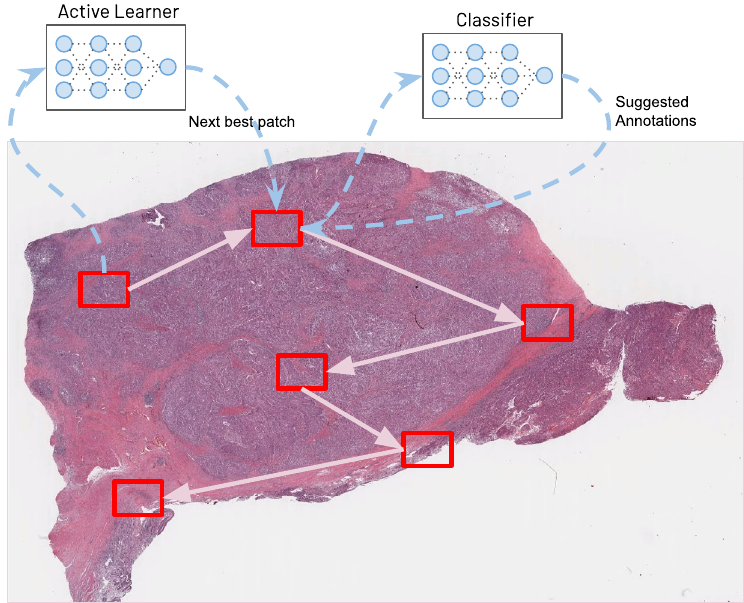
Fig. 1 HALS: human-augmenting AI-based labeling system. As a human annotator labels data, an active learning algorithm shuttles the annotator around the image by identifying the next best visual features to annotate. Simultaneously, other AIs make labeling suggestions designed to signi fi cantly accelerate annotation speed (not pictured — see Fig. 3. System Architecture). Together, they give annotators the ability to train personalized AI models, enabling them to generate high-quality labeled data sets for otherwise intractably large images. See Data Availability for image